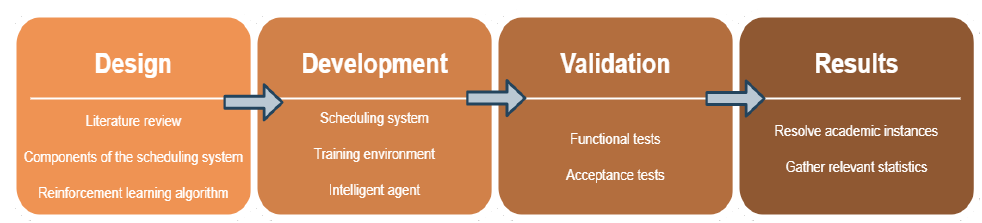
Figure 2. Diagram illustrating the principal activities of each